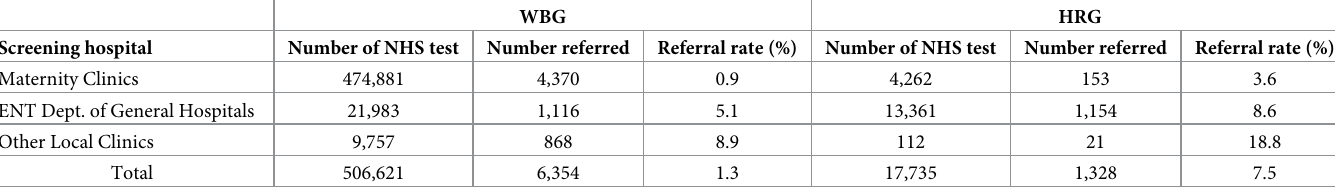
Table 3. Referral state from newborn hearing screening (NHS) according to screening hospital from 2010 to 2018 in Korea. WBG